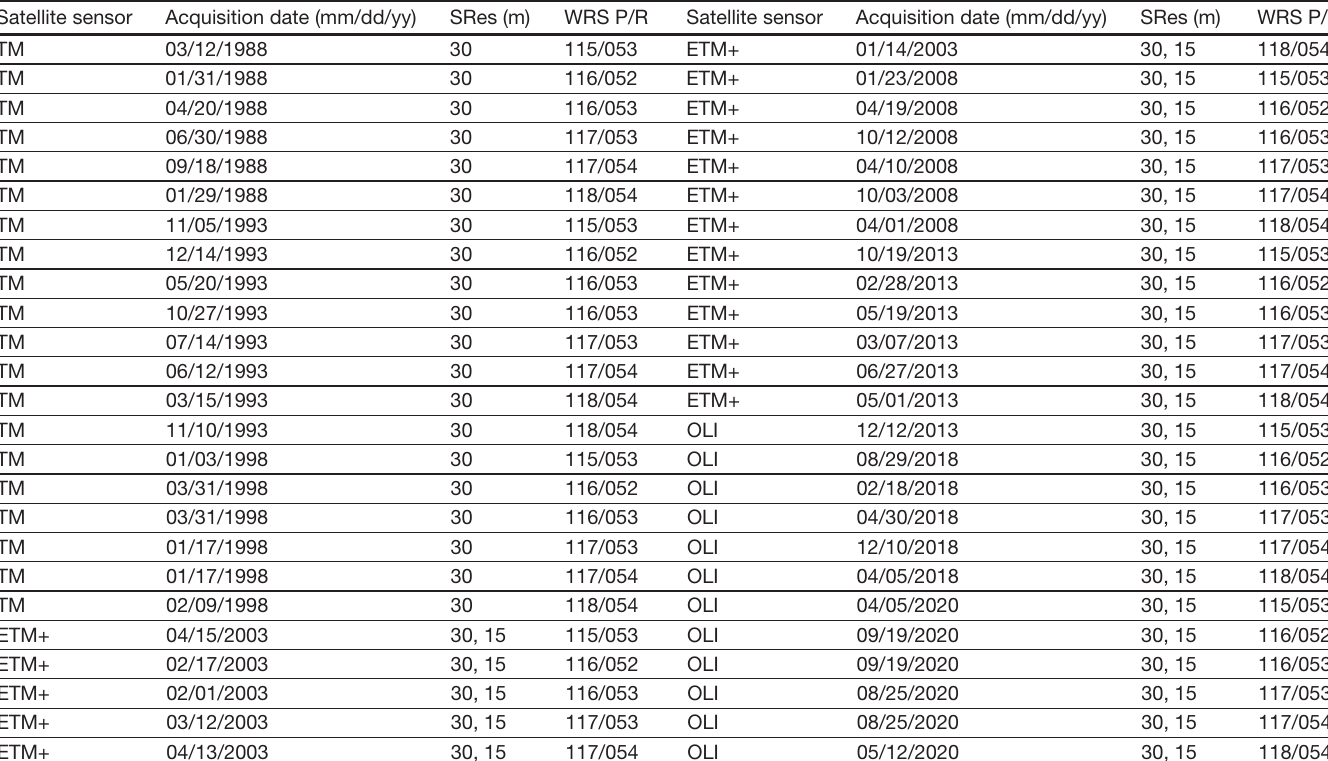
Table A2. Details of acquired Landsat satellite data selected for this study Satellite